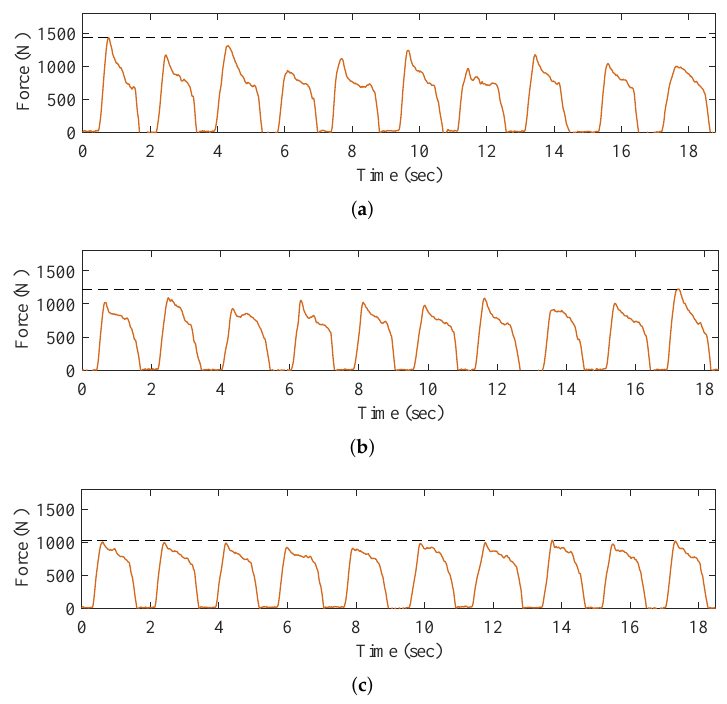
Figure 9. GRF data obtained from shoes sensors when walking at about 0.5 m/s. ( a ) The GRF data when walking with CG. ( b ) The GRF data when walking with MGA. ( c ) The GRF data when walking with MGB.